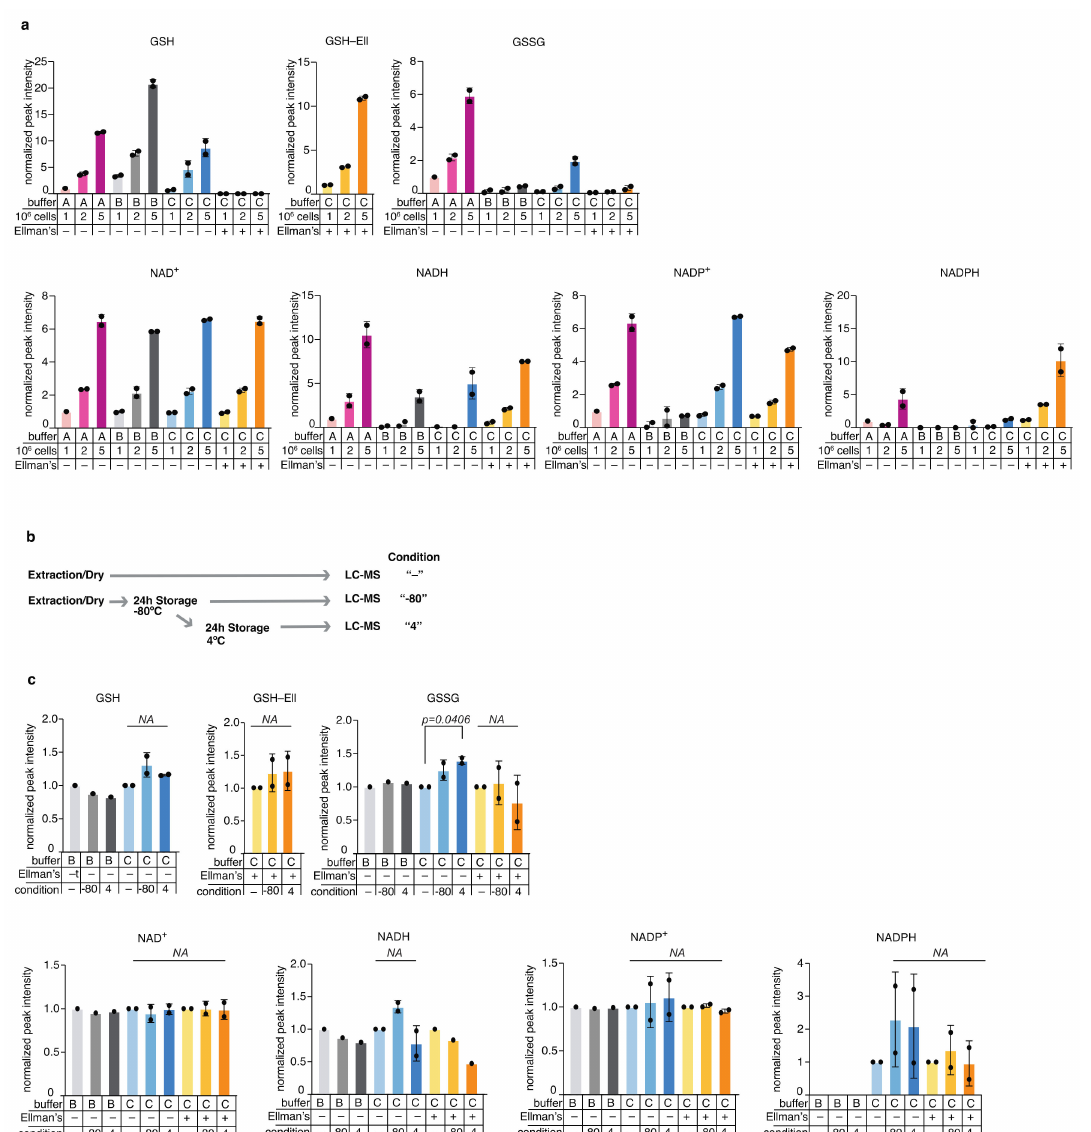
Figure 2. Optimization of redox metabolite detection in mammalian cells; ( a ) Comparison of metabolite detection in samples extracted from the mammalian cell line K562 using three extraction buffers (A, B, and C), with increasing number of cells (1, 2, or 5 million cells). Values were normalized to Buffer A/1 Million cells condition and present the average and standard deviation of two experimental replicates, each with technical duplicates (except for buffer A, 1M condition, which was measured once with a technical duplicate; ( b ) A scheme of the metabolite stability tests performed of various storage conditions: One million K562 cells were extracted immediately upon harvest and either analyzed by LC-MS immediately (labelled “-“), or analyzed after they were stored for 24 h at − 80 ◦ C (labelled “ − 80”), or analyzed following reinjection that followed additional 24 h incubation period at 4 ◦ C (labelled “4”); ( c ) Stability of redox metabolites extracted from 1M K562 cells in different storage conditions. Each storage condition was analyzed following extraction in the extraction buffers B and C. Values were normalized for each buffer to the corresponding “-” condition that involved no long storage. Presented are the average values and standard deviation of two independent experiments each with technical